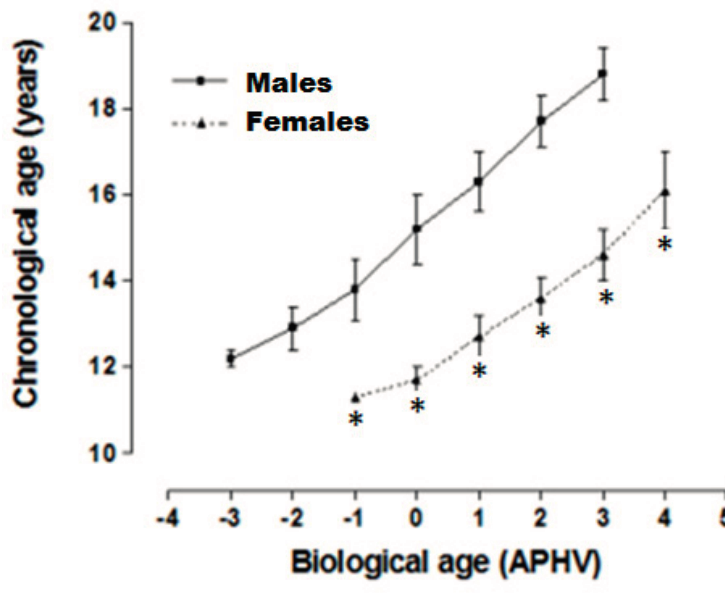
Figure 2. Relationship between chronological age (AC) and biological age (years from age at peak height velocity (APHV) of adolescents of both sexes from Arequipa (2320 m).